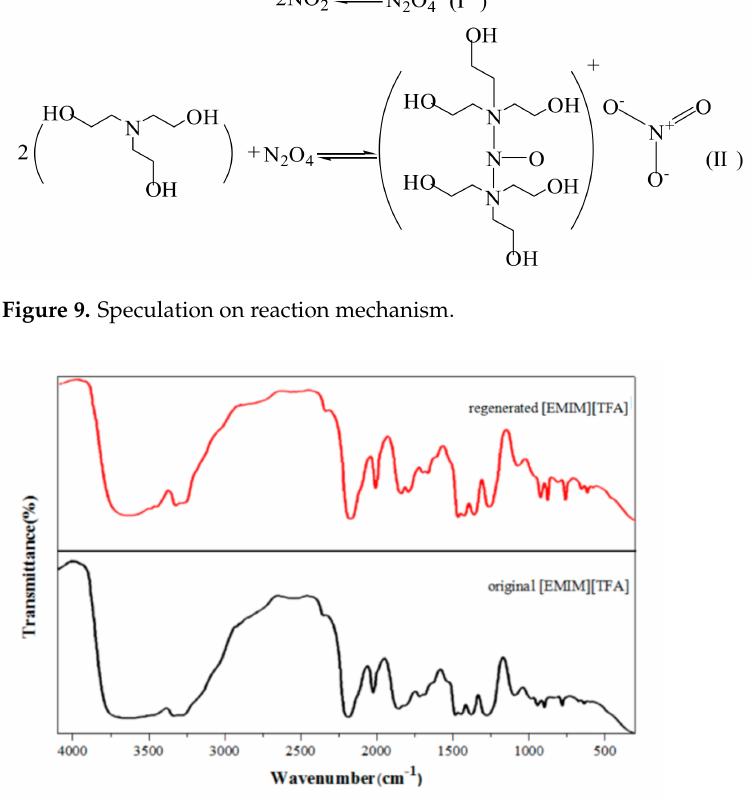
Figure 10. IR spectra of regenerated [EMIM] [TFA] and original [EMIM]